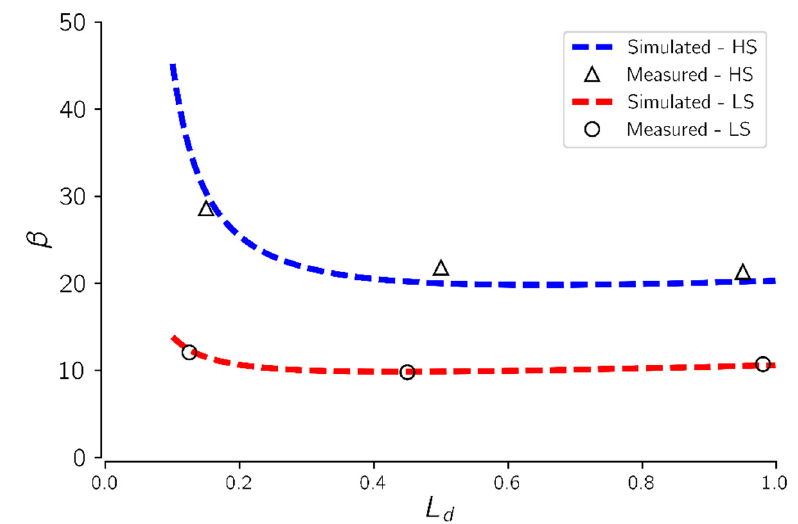
Figure 7. The impact of the dry-out length ( L d ) on CO 2 injectivity impairment ( β ) induced by salt precipitation. Magnitude of injectivity impairment increased when brine salinity was doubled from 75–150 g/L but successive changes in injectivity impairment was not influenced by change in brine salinity.